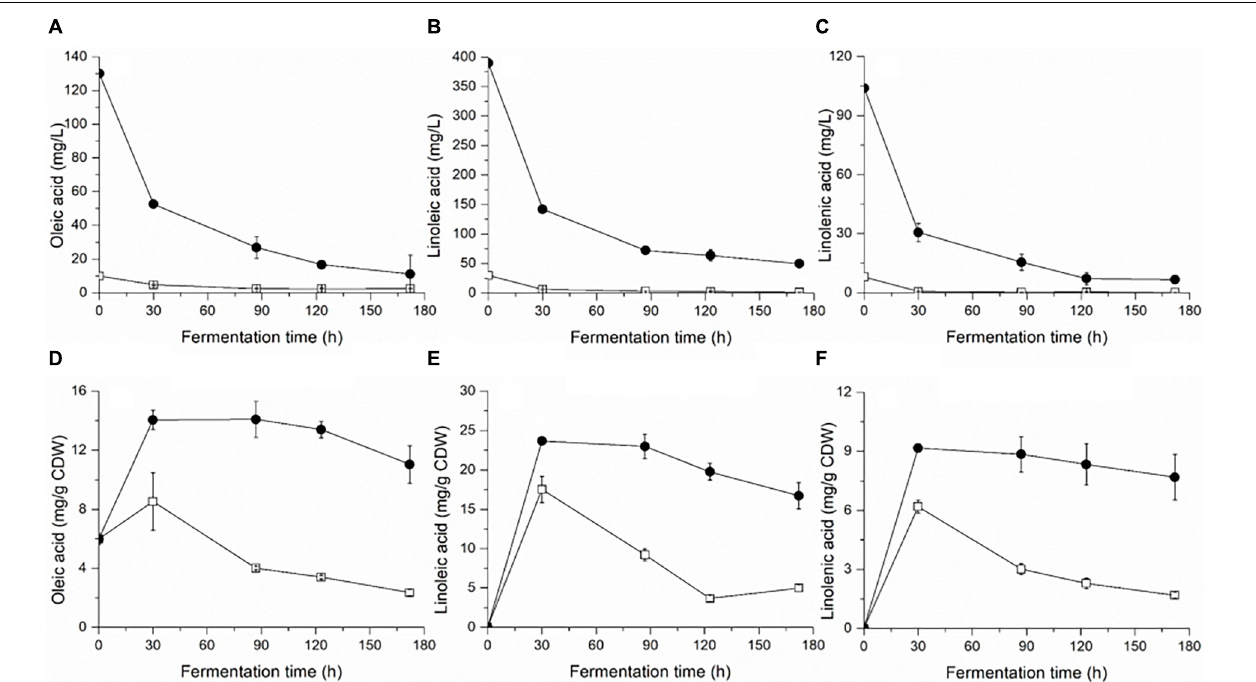
FIGURE 2 | Profiles of extracellular (A–C) and intracellular (D–F) fatty acids during the fermentation of MS300 media with high